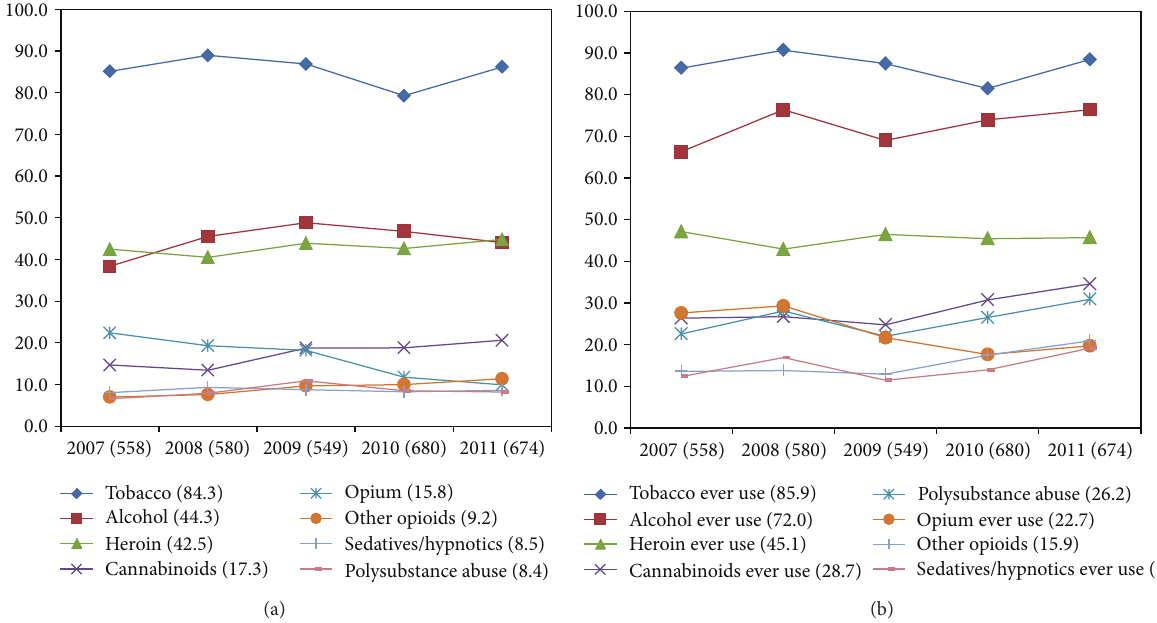
Figure 1: (a) Line diagram showing percentage distribution of common substances of abuse (current) in the respective years. Figures after the parentheses on x -axis denote total treatment seeking population in that year and the year after in legend showing the total percentage. (b) Line diagram showing percentage distribution of common substances of abuse (ever) in the respective years. Figures after the parentheses on x -axis denote total treatment seeking population in that year and the year after in legend showing the total percentage.